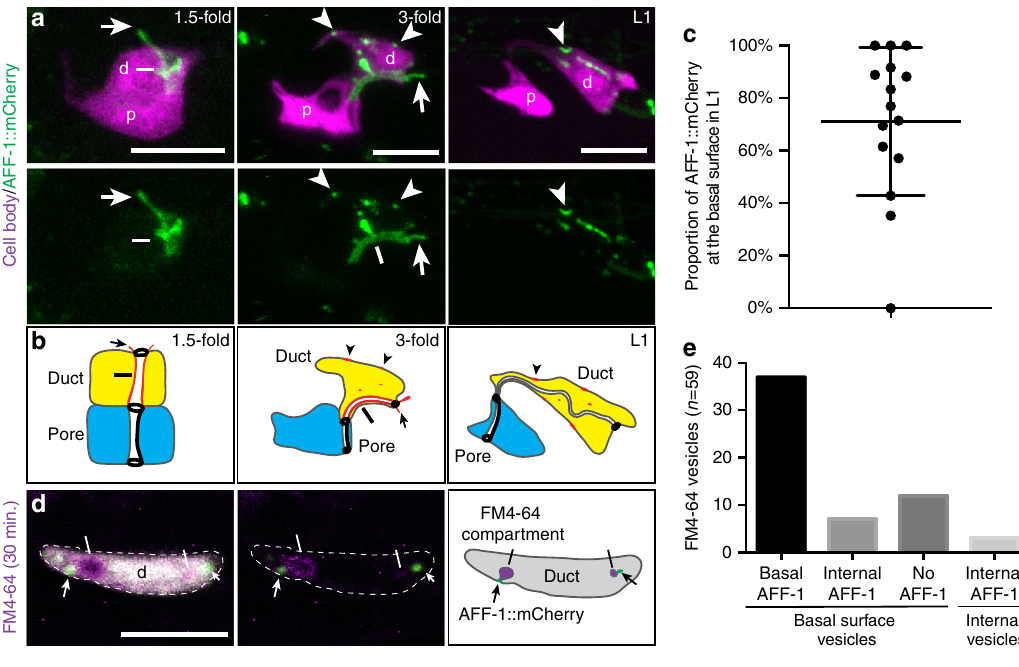
Fig. 6 AFF-1 localizes to sites of auto-fusion and basal endocytosis. a Confocal Z-projections at different developmental stages in wild-type, d, duct; p, pore. The excretory duct and pore cell bodies are labeled with grl-2pro::YFP (magenta) and AFF-1 localization visualized with aff-1pro::aff-1::mCherry (green). At the time of duct auto-fusion, in 1.5-fold stage animals, AFF-1::mCherry localizes predominantly at the apical surface of the duct cell (line). The signal also extends dorsally (arrow); since the duct is the only aff-1 expressing cell in this region at this stage (Fig. 1e), the extension presumably corresponds to an extension of the duct apical domain into a neighboring cell such as the excretory canal tube or excretory gland, with which the duct lumen connects 31 . The localization of AFF-1::mCherry progressively shifts to become cytoplasmic and basal (arrowheads) in later stages. In L1 stage, AFF-1::mCherry is still present >6 h after duct auto-fusion. b Schematic interpretation. c Volocity quanti fi cation of the proportion of AFF-1::mCherry at the basal membrane in L1 larvae. Error bars = ± SD. d Confocal single slice of a wild-type L1 larva. AFF-1::mCherry (green) localizes adjacent to FM4-64-marked endocytosing vesicles (magenta and white bar) at the basal membrane of the duct cell (gray). e Quanti fi cation of the four categories of FM4-64 positive vesicles.